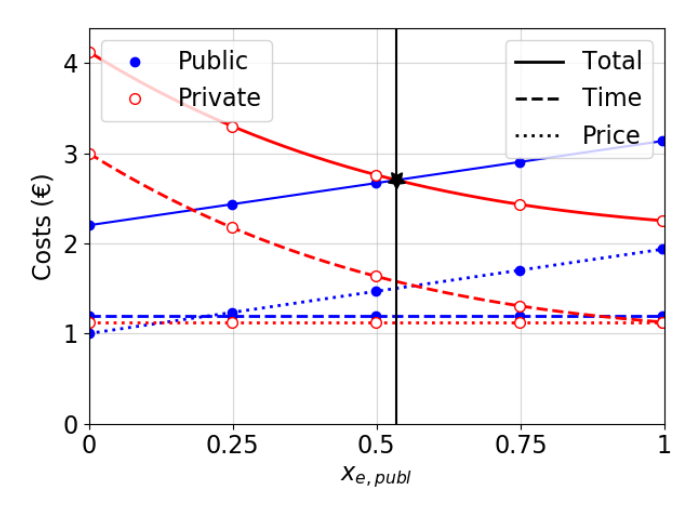
Figure 6. EV costs as a function of the proportion x e , publ of EV choosing public transport. In blue (resp. red) is the cost for EV choosing public (resp. private) transport mode. The dotted lines refer to the monetary costs (consumption and ticket fare for public mode; only consumption for private mode) and the dashed lines refer to travel duration. The equilibrium (black star) happens when total costs are = equal between the two transport modes, for x e , publ = x ∗ e , publ